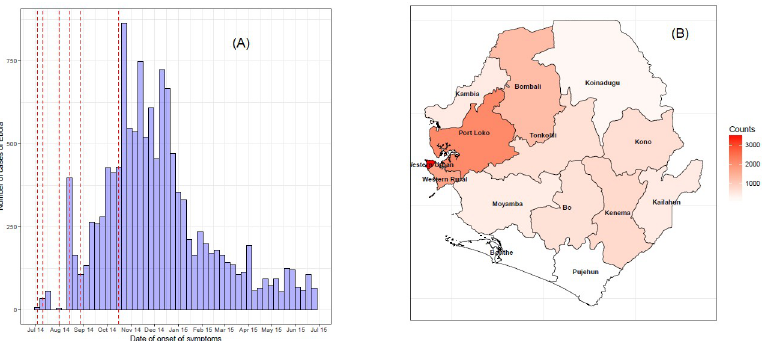
Fig 1. Data from 2014 Ebola outbreak in Sierra Leone from July 3, 2014 to June 27, 2015. (A) Daily counts of Ebola weekly counts. The red dotted vertical lines show the starting points of the epidemic in districts where the epidemics starts later. (B) Total number of Ebola cases by